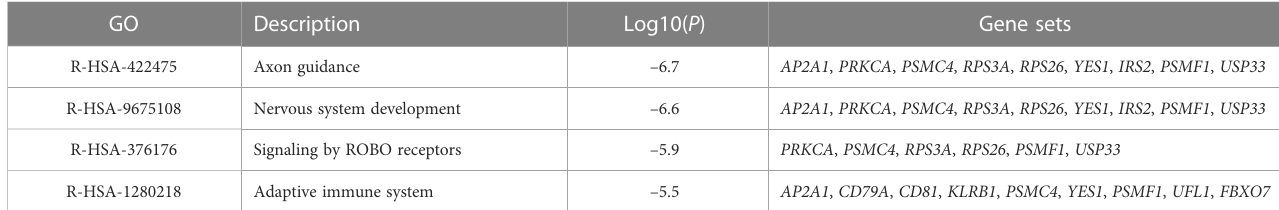
TABLE 1 The top four GO MCODE components identi fi ed in 95 consistently changing DEGs in the protein-protein interaction network.